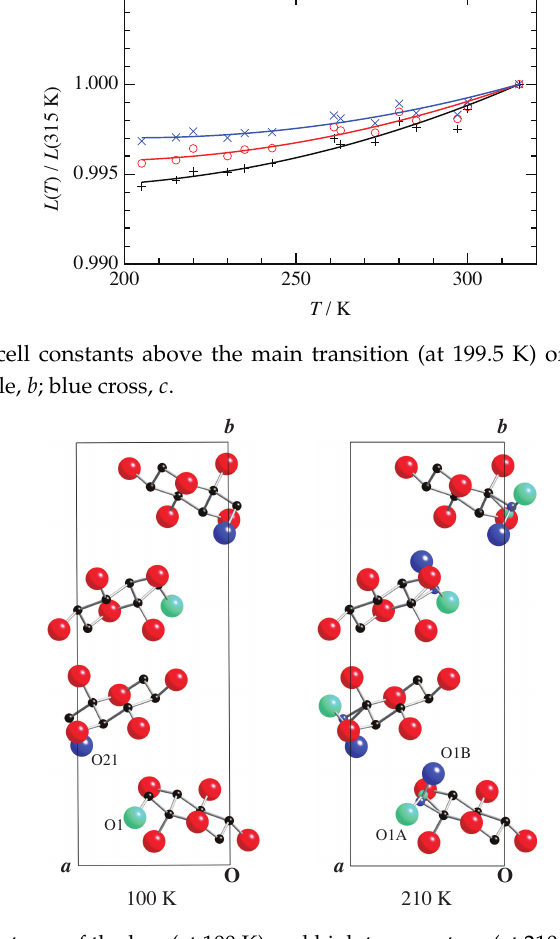
Figure 6. Crystal structures of the low (at 100 K) and high temperature (at 210 K) phases of D -sorbose viewed along the c -axis. Green and blue balls on the right are the major and minor components of the disordered oxygen atom in the high temperature phase. Hydrogen atoms are not shown for